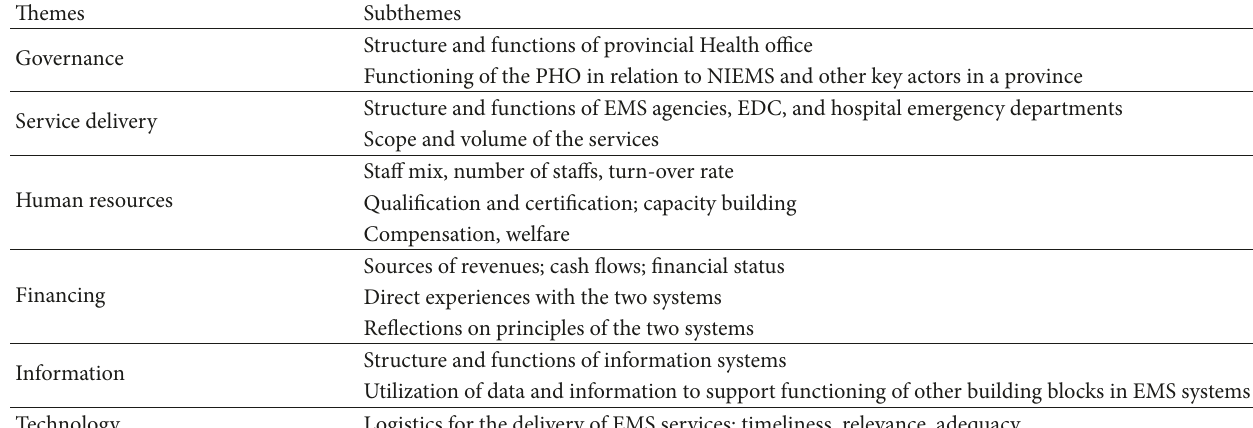
Table 2: List of themes and subthemes for guiding data gathering in focus-group or individual interview sessions.